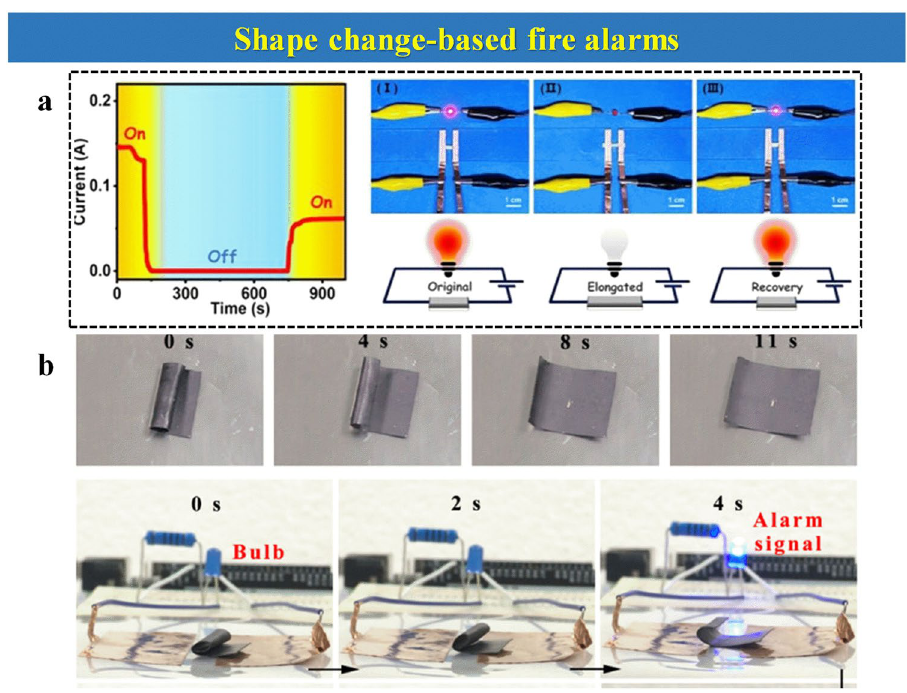
Fig. 10 a Real‑time monitoring of current changes during stretching and shape recovery process via float device and electrochemical worksta‑ tion at a given voltage of 0.1 V. and Using LED indicators to evaluate the conductivity of sample in its initial state, stretched state, and shape‑ restored state. Reproduced with permission from Ref. [95]. Copyright 2022 Elsevier. b The shape recovery process of rolled‑up SMPU/MXene paper and the application as an EFWS. Reproduced with permission from Ref. [58]. Copyright 2021